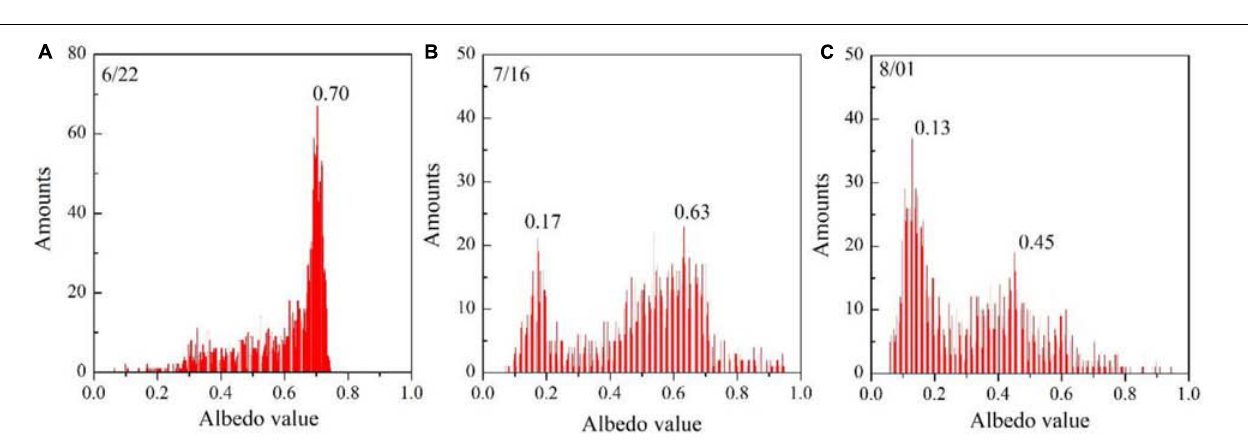
FIGURE 4 | Spatial distribution of the surface albedo of Urumqi Glacier No. 1 in the 2006 ablation season.